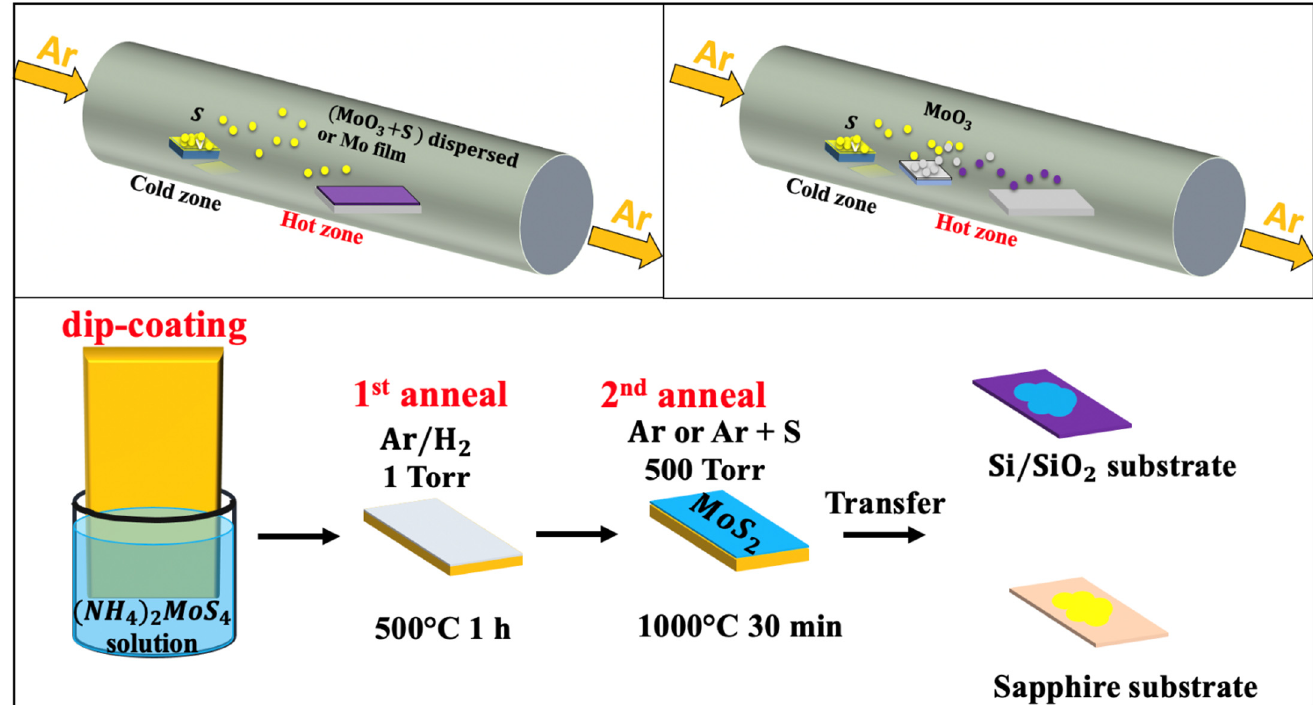
Figure 2. Schematic of the chemical vapor deposition techniques: ( a ) thermal vapor sulfurization process using a quartz tube; ( b ) thermal vapor deposition process using a quartz tube; and ( c ) thermal decomposition of (NH 4 ) 2 MoS 4 (reproduced and adapted from Ref.